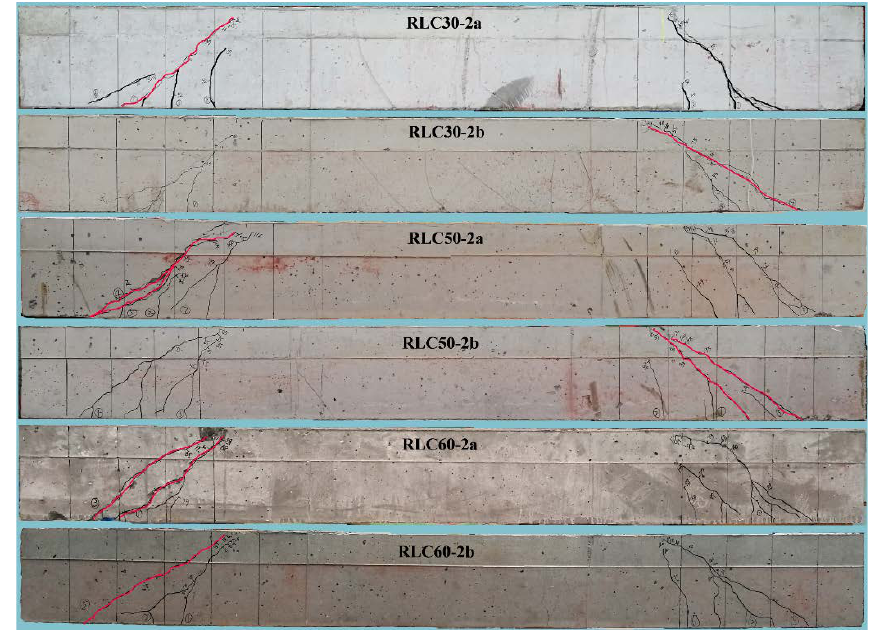
ff erent CRAC strength.